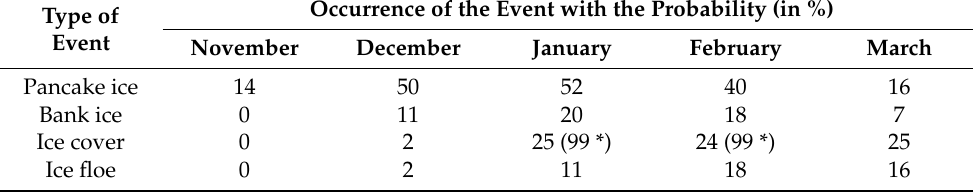
Table 7. Ice conditions on the lower part of the Vistula River (based on data from 1981–2016 collected by IMGW-PIB). Occurrence of the Event with the Probability (in %) Type of Event November Pancake ice 14 Bank ice 0 11 20 7 Ice cover 0 2 25 (99 *) 24 (99 *) 25 Ice floe 0 2 11 18